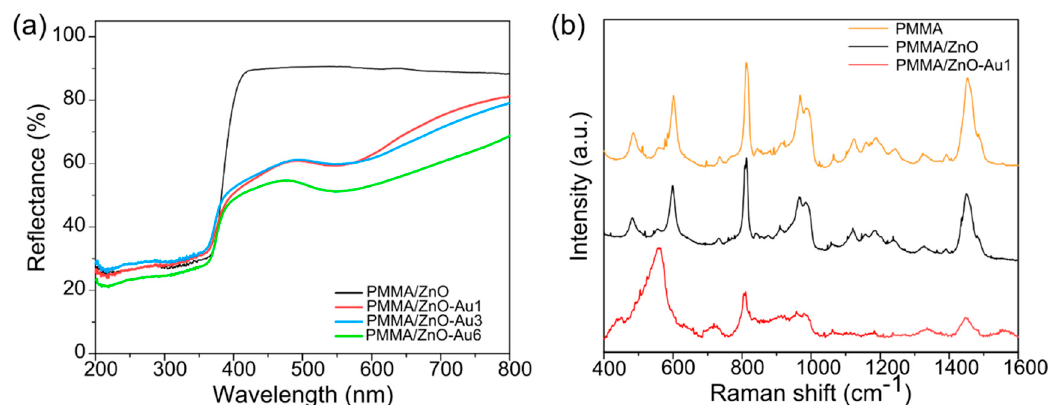
Figure 4. ( a ) Diffusive reflectance spectra of the developed composite mats. ( b ) Raman spectra of the polymeric fibers and of the PMMA/ZnO before and after the superficial modification with Au NPs. The formation of the Au/ZnO NP hybrid structures was confirmed by Raman spectroscopy.